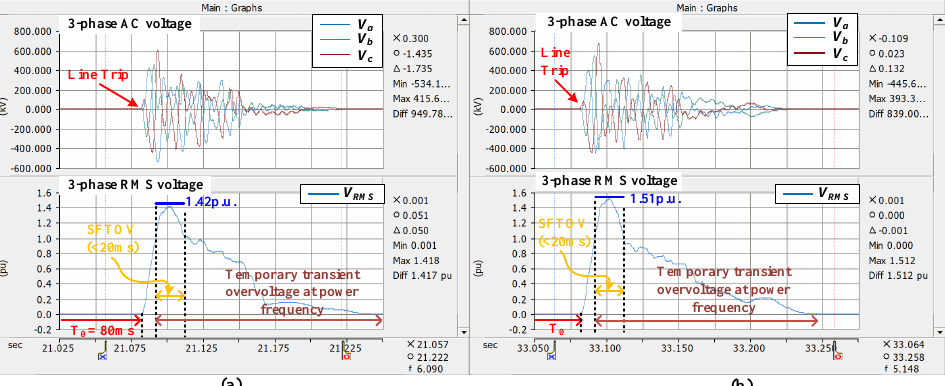
Figure 13. PSCAD/EMTDC simulation results according to generator operation and LCC-HVDC system operation conditions. ( a ) The 730-MW operating condition of LCC-HVDC system and ( b ) the 740-MW operation at 48% of full-rated power of LCC-HVDC